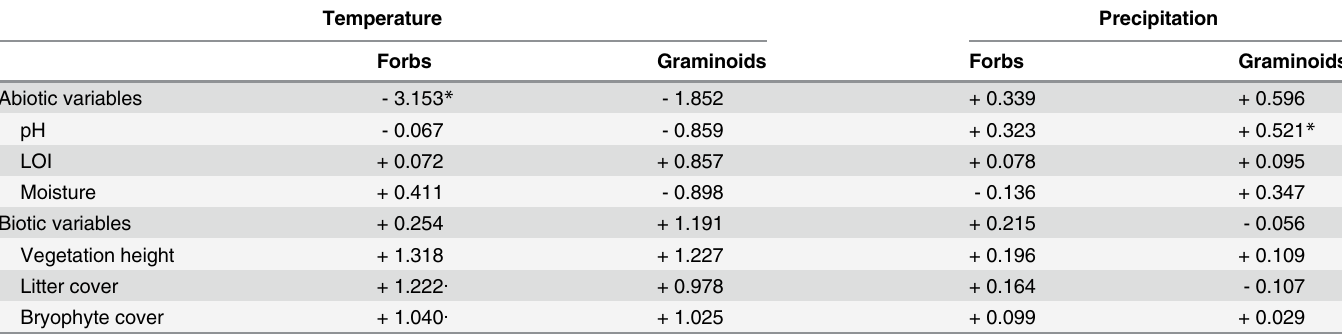
Table 2. Regression slopes and associated p-values ( * p < 0.05, · p < 0.1, no symbol = not significant) of relationships between variation in forb and graminoid species composition explained by local abiotic and biotic environmental variables in redundancy analyses (RDA) of local grass- land species composition along broad scale temperature and precipitation gradients in southern Norway.